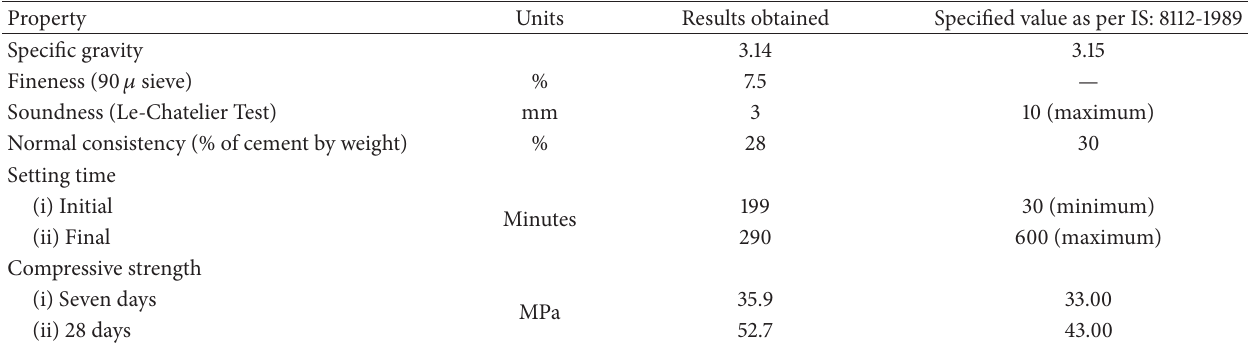
Table 1: Physical properties of cement.